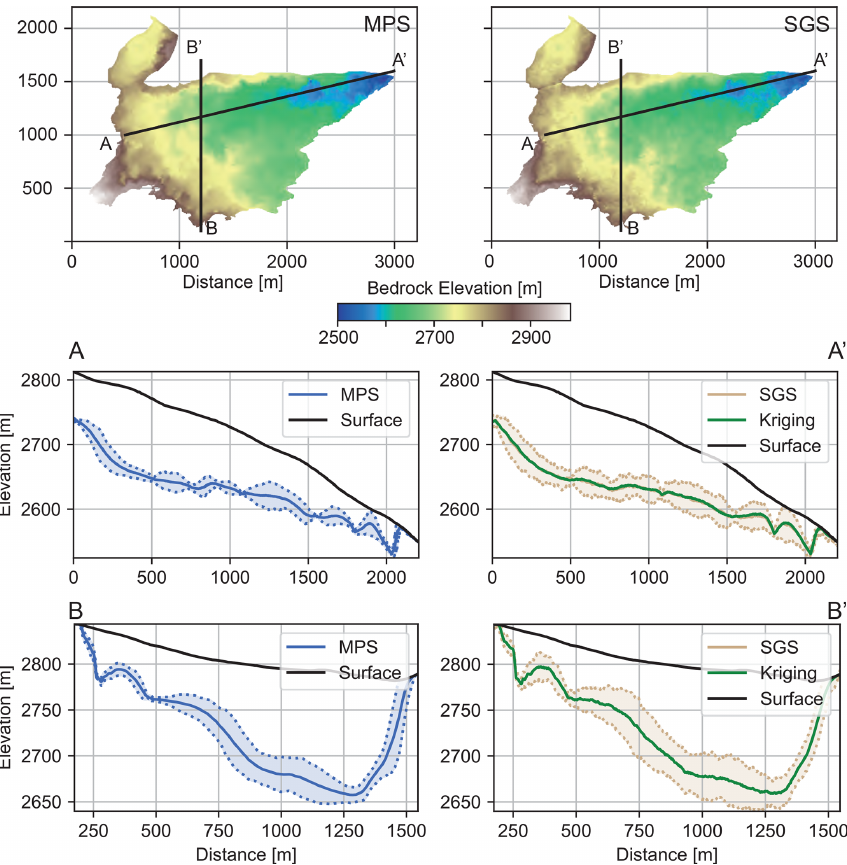
Figure 8. Simulated basal topography for the MPS method (in blue) and for the SGS method (in brown). The kriging-estimated topography is displayed alongside the SGS simulation in